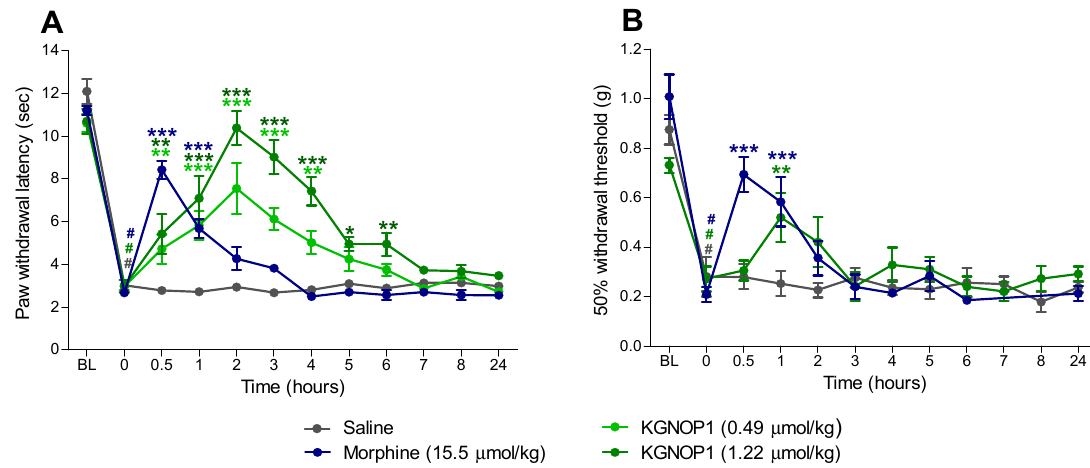
Figure 3. Antinociceptive effect of KGNOP1 and morphine after s.c. administration to mice with CFA-induced inflammatory pain. Groups of mice received s.c. saline (control), KGNOP1, or morphine, 72 h after i.pl injection of CFA in the right hindpaw. Paw withdrawal latencies to thermal (Hargreaves test, A ) and mechanical stimulation (von Frey test, B ) were determined before (baseline, BL), 72 h after CFA injection (0 h), and at different time points up to 24 h after drug administration. Data are presented as the mean ± SEM (n = 6–8 mice per group). * p < 0.05, ** p < 0.01, and *** p < 0.001 vs. saline group, two-way ANOVA followed by Bonferroni’s post hoc test; # p < 0.001 vs. baseline (BL) pre-inoculation values, paired t -test.